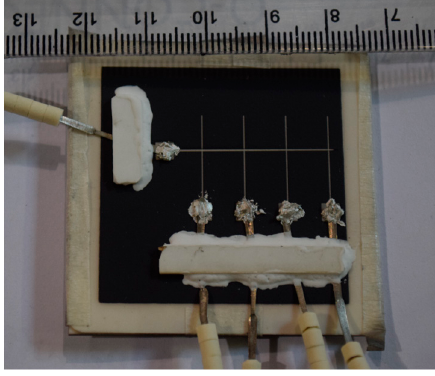
Figure 2 . External wires attached to the thin film thermoelement pads.